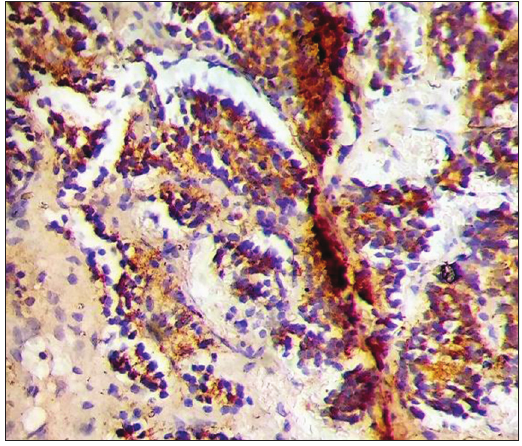
Figure 2: Histopathology showing round tumor cells arranged in small clusters and also scattered singly (H and E stain, ×4 magnification)